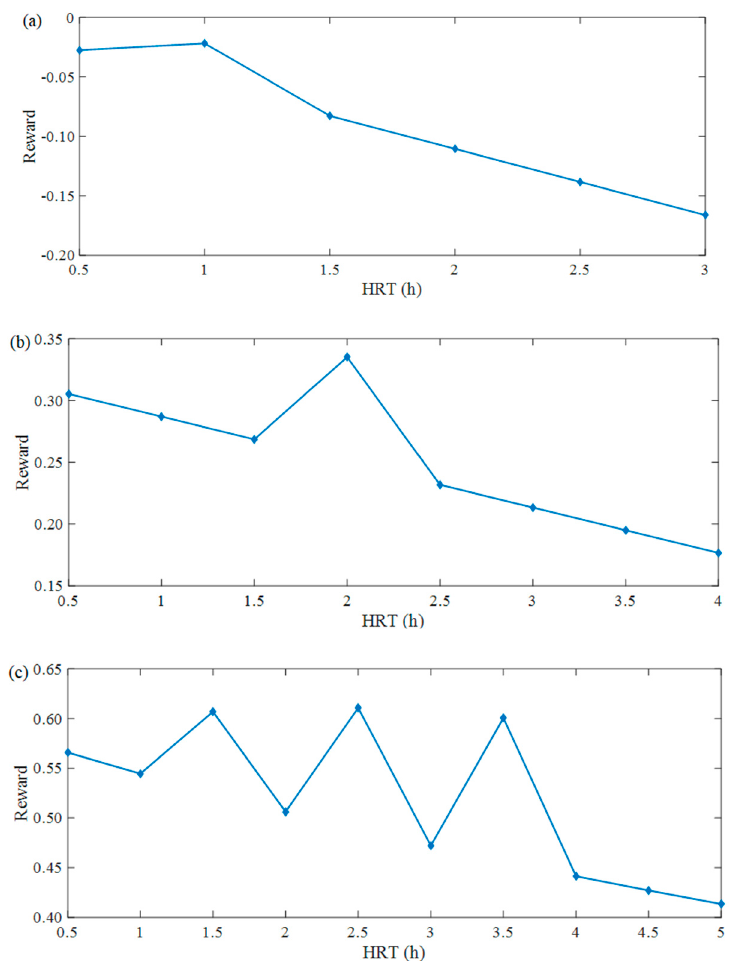
Figure 6. The pair of <reward-action> for HRTs optimization for ( a ) anaerobic tank, ( b ) anoxic tank, and ( c ) oxic tank.